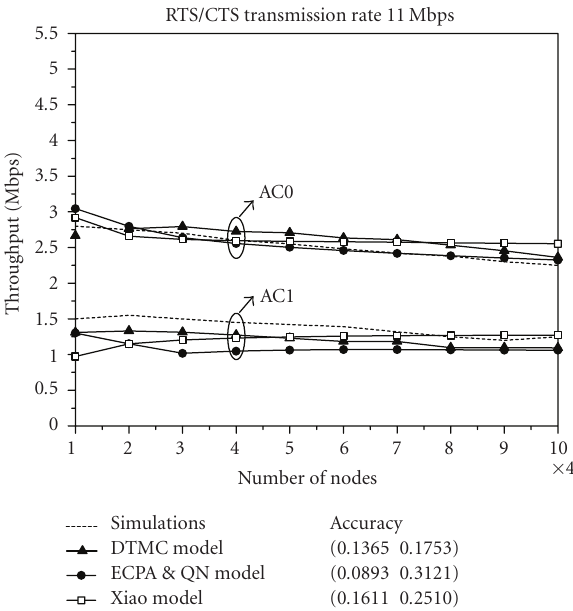
Figure 6: Model comparison in terms of saturation throughput us- ing RTS/CTS access method at 11 Mbps transmission rate.